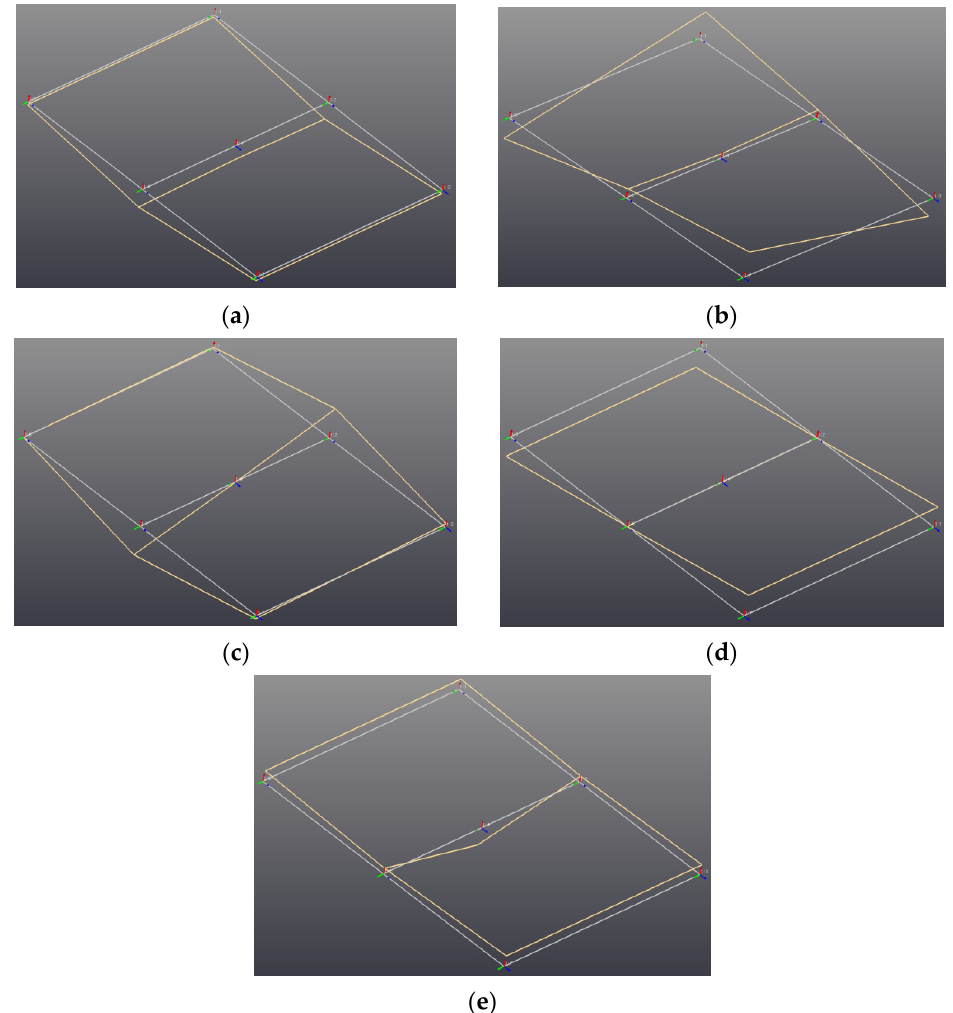
Figure 5. Experimental mode shapes of the simple specimens (yellow line), overlapped with the original model (white line): ( a ) first mode (first bending); ( b ) second mode (first torsional); ( c ) third mode (second torsional); ( d ) fourth mode (second bending); ( e ) fifth mode (third bending).